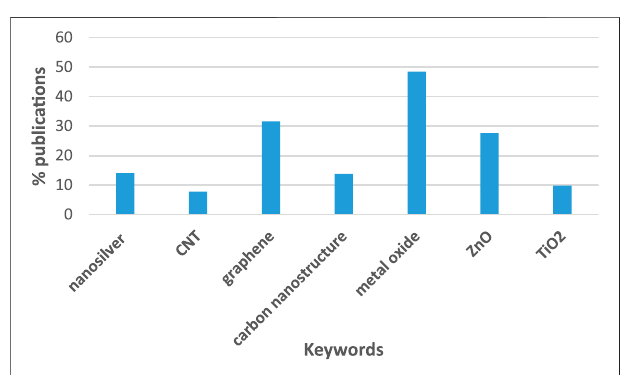
FIGURE 3 | Percent of publications dealing with nanostructure-based antifouling solutions. The results include publications from January 1, 2000 to July 19, 2020 performed by SCOPUS search. The searchincludedkey words “ nanotechnology ” and “ biofouling ” plus one of the key